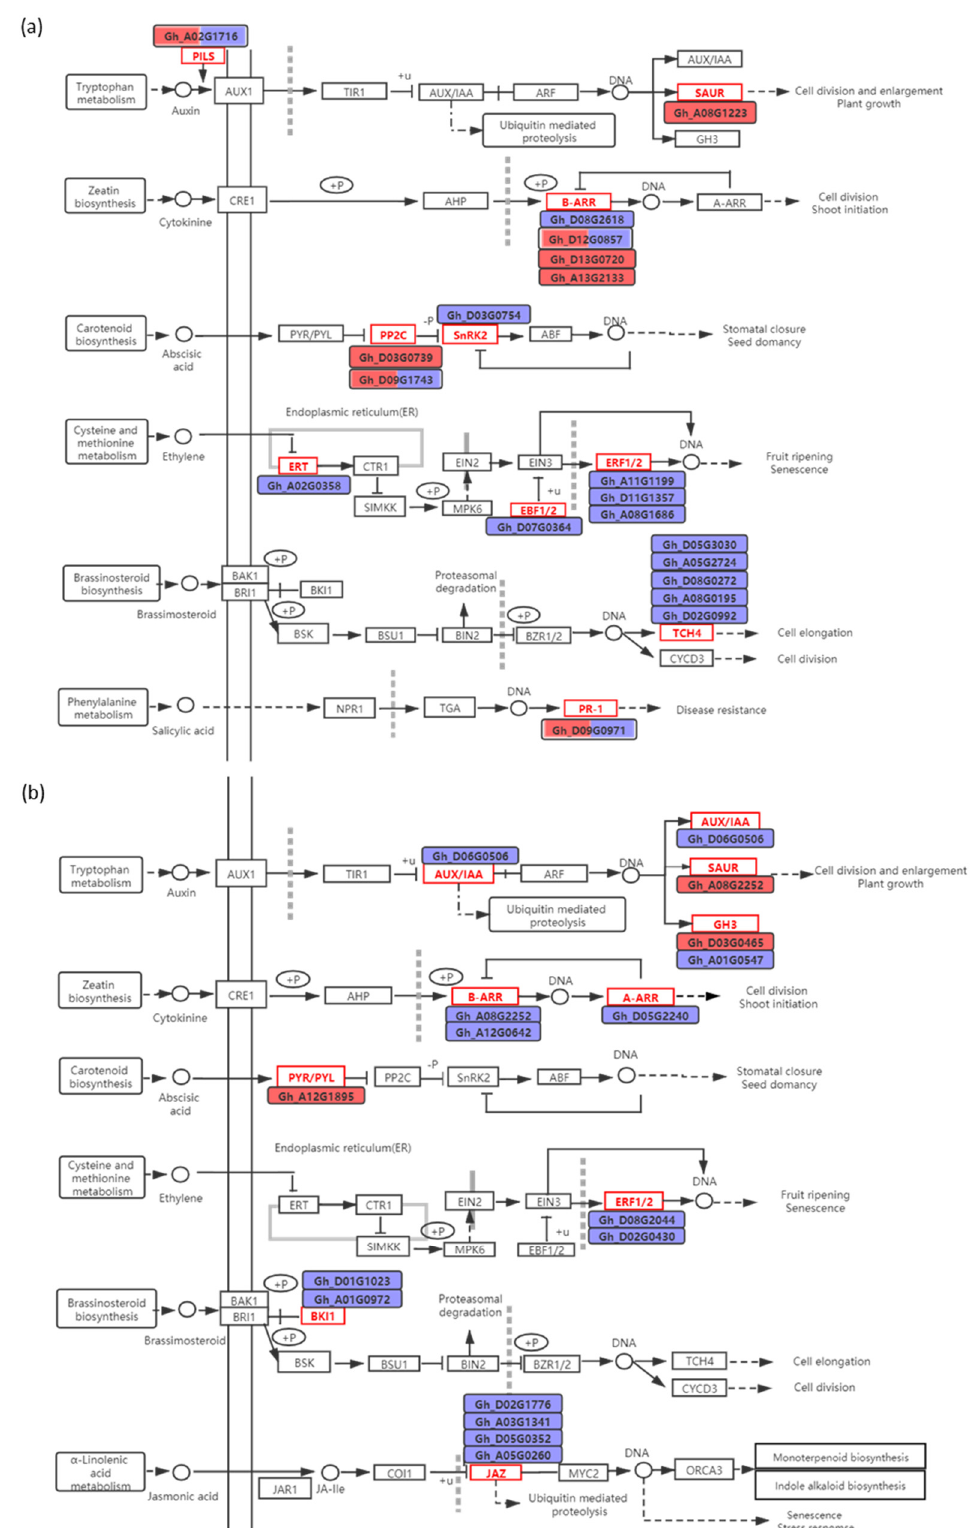
Figure 5. The differentially expressed genes (DEGs) involved in phytohormone signaling in R common ( a ) and R 22/41 unique ( b ) group. R common: Common DEGs in roots of CCRI41/CCRI41 (scion/rootstock) and SCRC22/CCRI41 under potassium (K + ) deficiency. R22/41 unique: DEGs specifically identified in roots of SCRC22/CCRI41. Red and purple boxes contain genes that were up- and down-regulated, respectively. The red and blue colored boxes contain genes that were oppositely regulated in both grafts, the left and right boxes were assigned to CCRI41/CCRI41 and SCRC22/CCRI41, respectively. The “DNA” in diagram represents undefined genes.